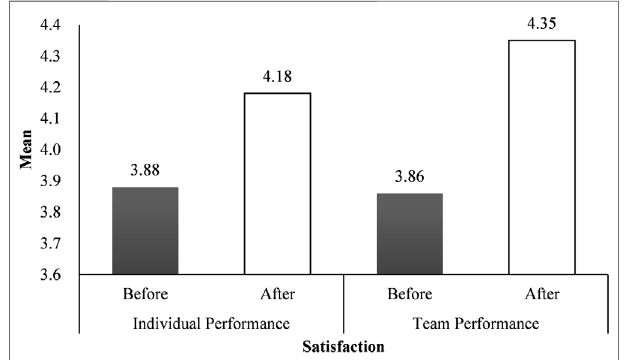
FIGURE1| Satisfactioncomparisonchartofindividualperformanceand team